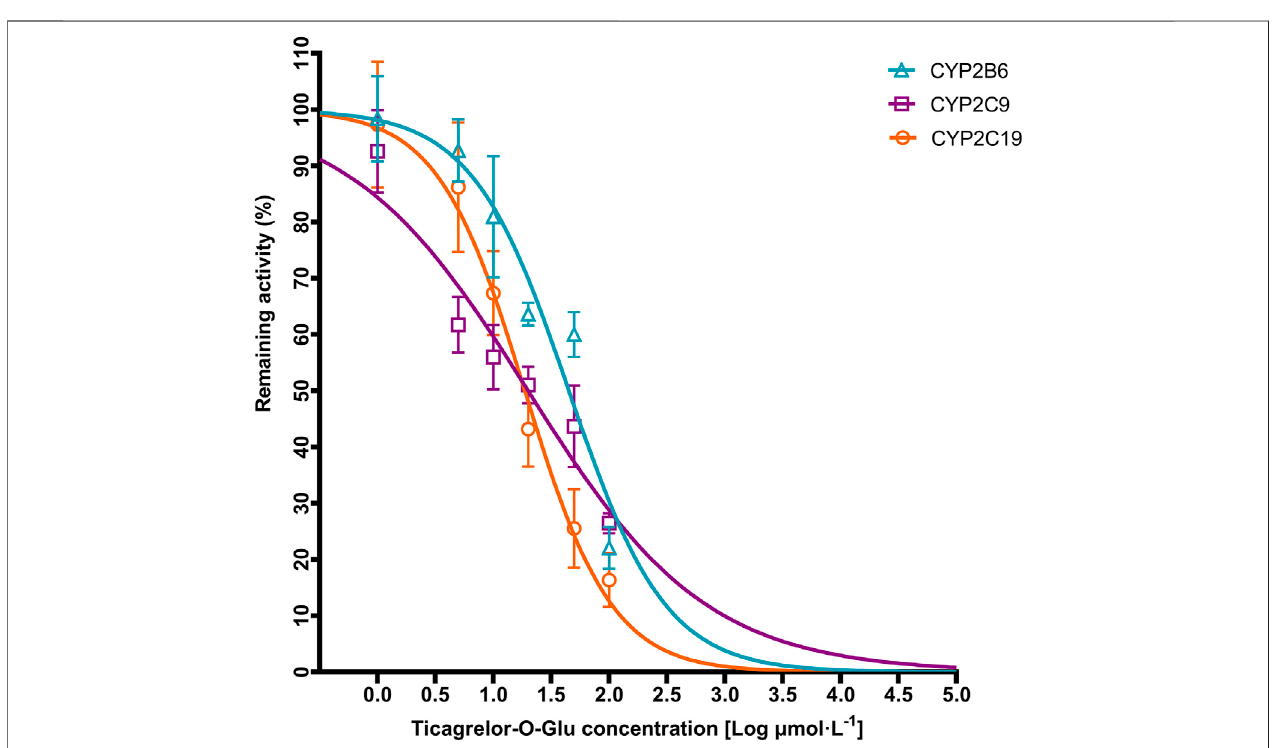
FIGURE 8 | Representative IC 50 plots demonstrating the inhibitory effect of ticagrelor-O-Glu at concentration of 0 – 100 µM on the activities of CYP2B6, CYP2C9, and CYP2C19.